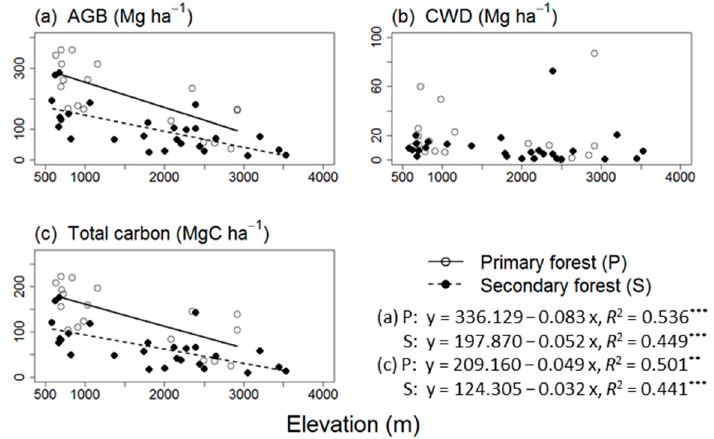
Figure 2. Relationships of elevation with ( a ) aboveground biomass (AGB), ( b ) coarse woody debris (CWD), and ( c ) the total carbon stock for the sampled forest sites in the Cusco region of Peru. Solid and dashed lines denote significant linear regressions. Significance levels: ** p < 0.01; *** p < 0.001.